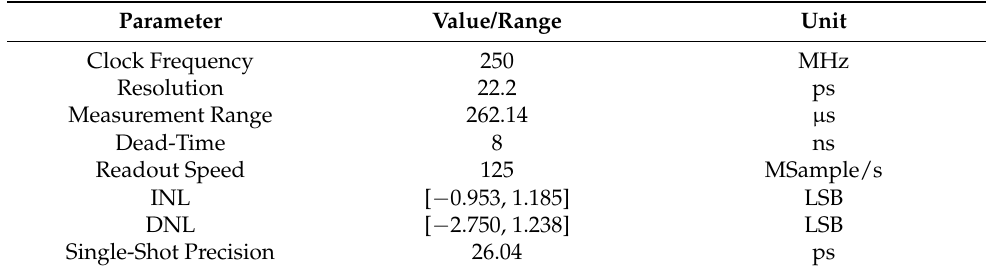
Table 4. Characteristics of the proposed